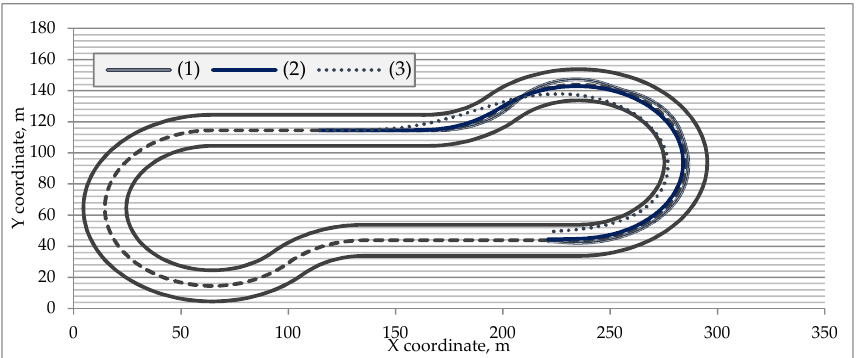
Figure 14. Different types of the car trajectory behavior depending on the prediction time. From (1) to (3), this duration becomes longer.